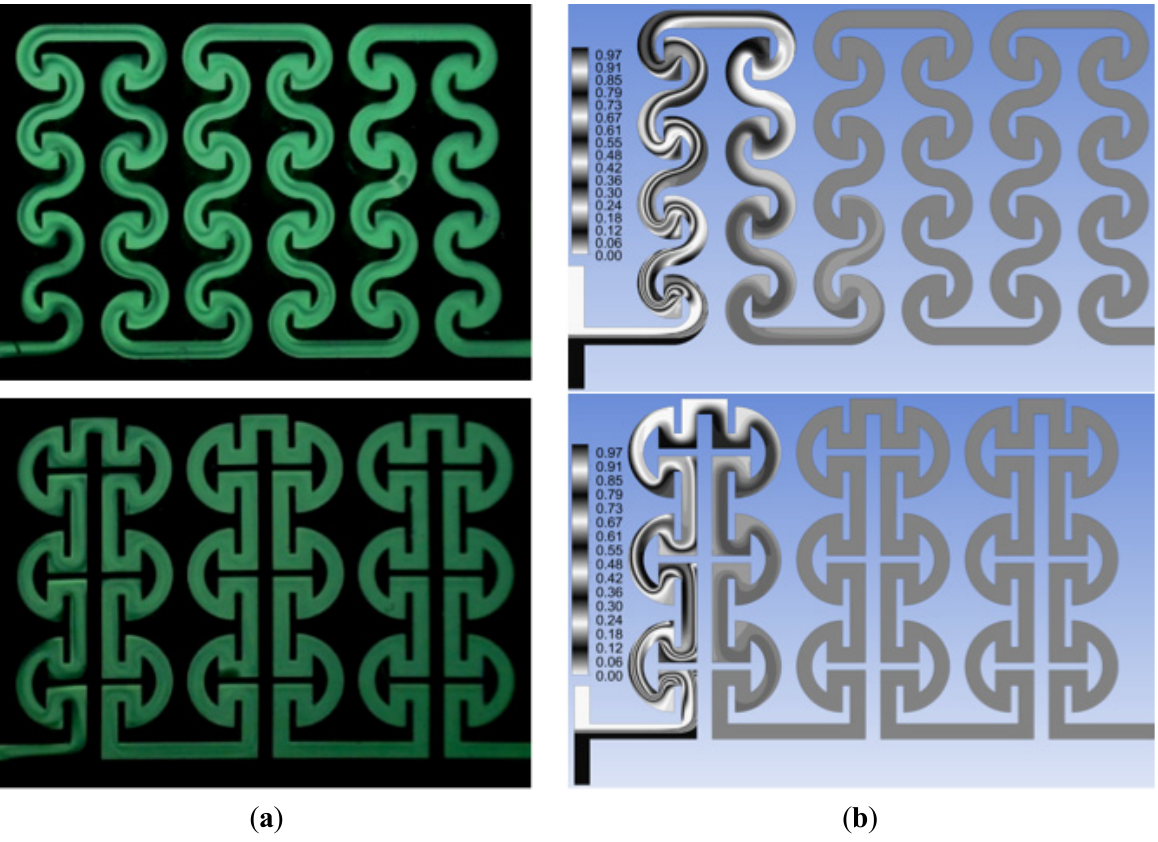
Figure 14. Visualization and comparison of mixing results for experiments ( a ) and numerical contours ( b ) at Re = 50 in Ω micromixer design